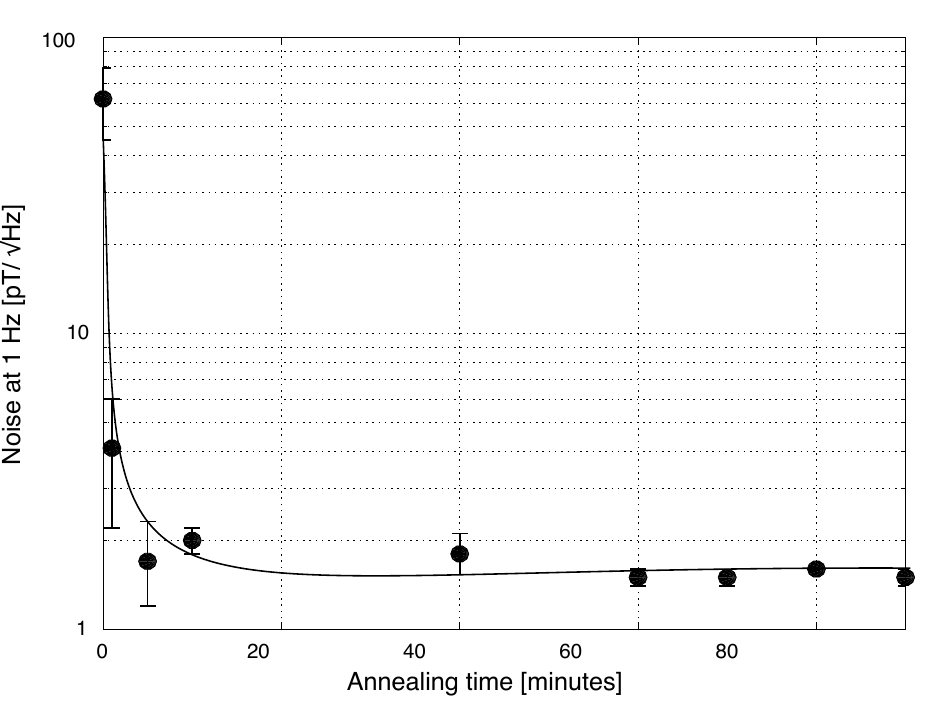
Figure 7. Noise at 1 Hz of a fluxgate magnetometer based on a wire with a nominal composition of ( Co ) 72.5 Si 12.5 B 15 , produced at the Institute of Material Sciences of Madrid vs. annealing 0.942 Fe 0.058 time, together with fitting